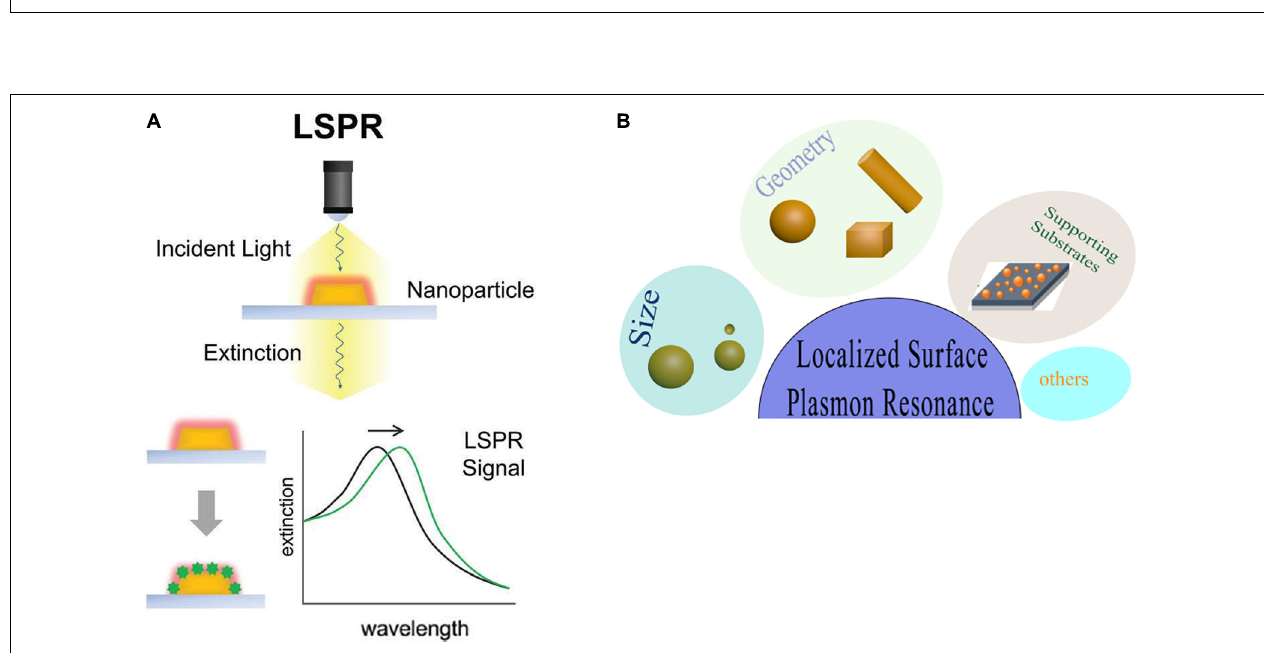
FIGURE 2 | Local surface plasmon resonances (LSPR). (A) The measurement principles and spectral signatures of LSPR. Reprinted with permission from Jackman et al. (2017), Copyright (2017) American Chemical Society. (B) Physical effect of LSPR engineered by size, geometry, supporting substrates, and so on.